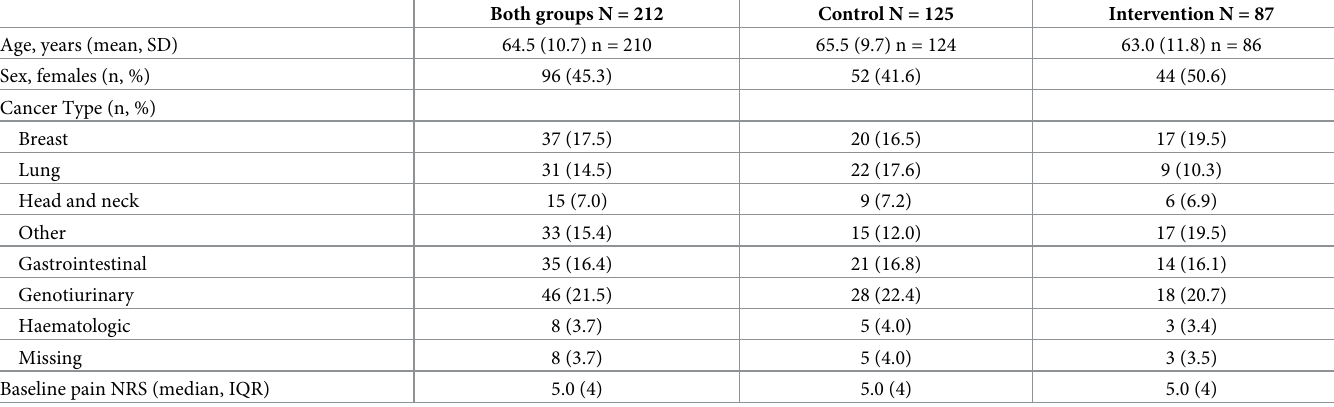
Table 1. Participant demographics and clinical